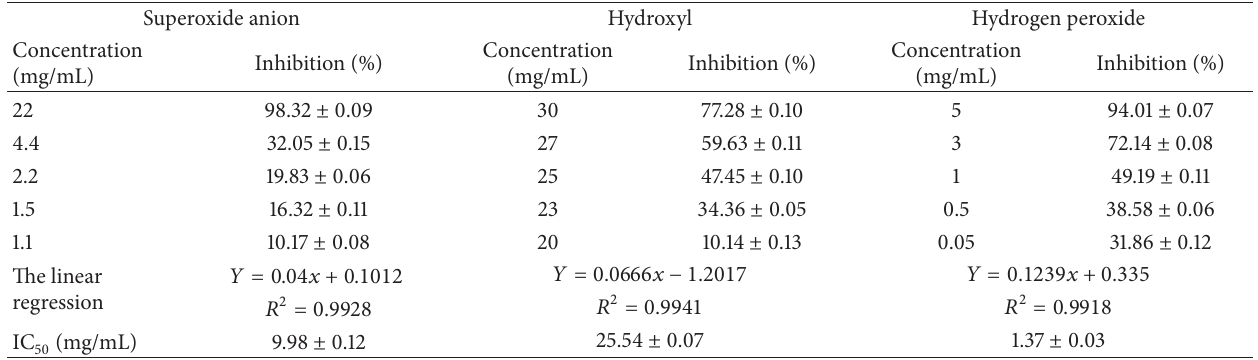
Table 1: Capacities of antioxidation of ophiurasaponin 𝑛 = 6 .